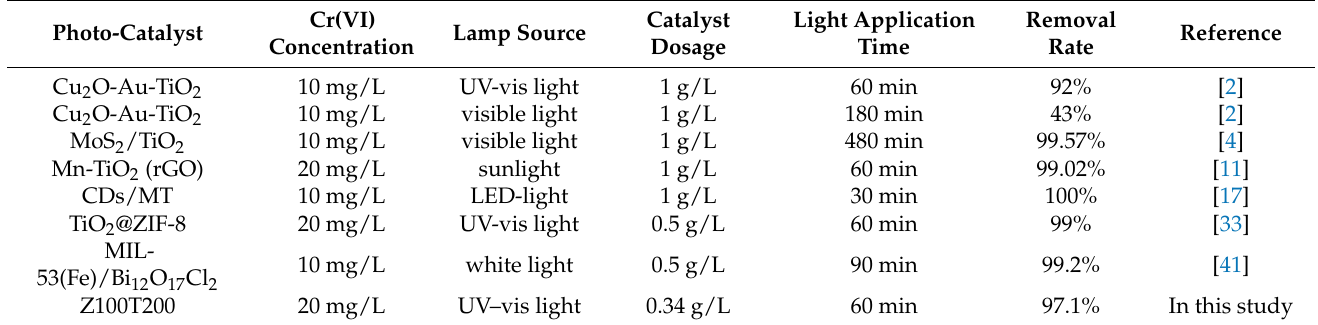
Table 1. Treatment of Cr(VI) with different photocatalytic